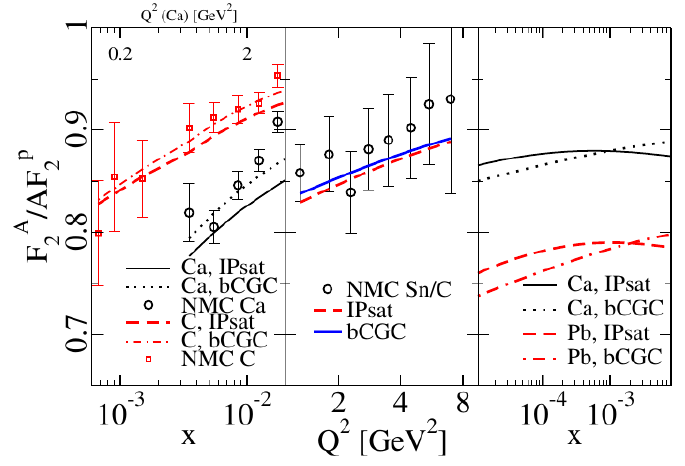
Figure 12. Predictions for shadowing compared to data from the New Muon Collaboration. Center: predictions for Right: Predictions for Q 2 = 5 GeV 2 as a function of x . Figure from the work in